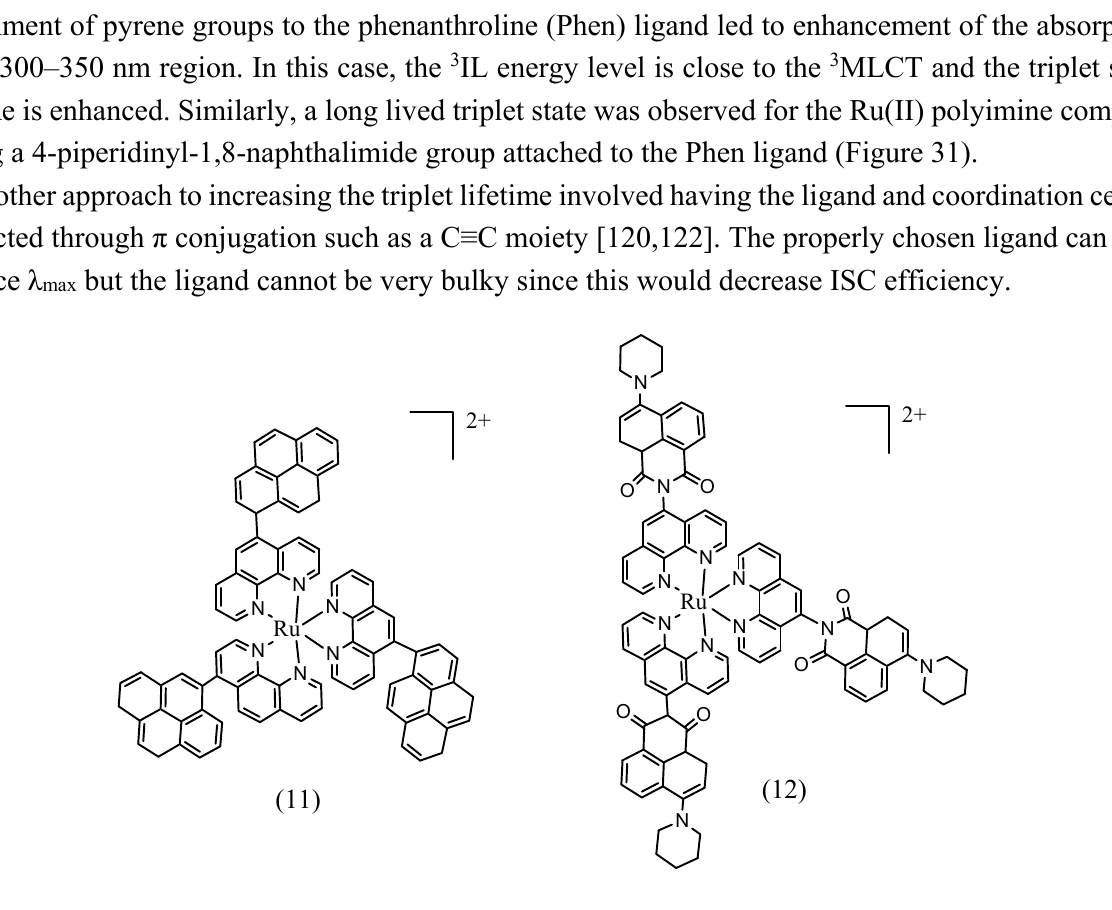
Figure 31. Example Ru(II) based phen complexes having close 3 MLCT and 3 IL